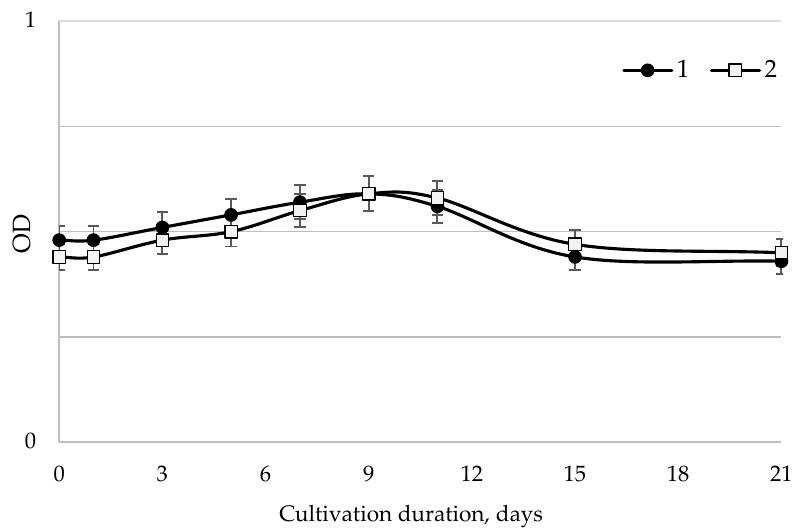
Figure 1. The dependence of the optical density of the Filinskaya Bay microalgae suspension on cultivation time: 1— S. intermedius ; 2— S. obliquus .